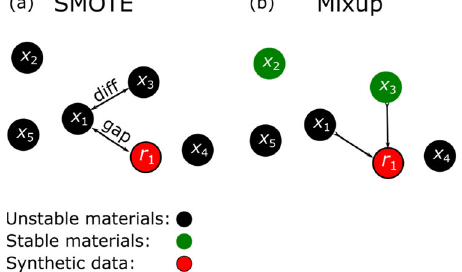
Fig. 4 Generation of synthetic data points using SMOTE and Mixup. a In SMOTE, the data point r 1 is obtained from the two minority data points x 1 and x 3 using the formula r 1 = x 1 + gap × diff. b In Mixup, r 1 is obtained from the minority x 1 and majority x 3 using the formula r 1 = (1 – λ ) x 1 + λ x 3